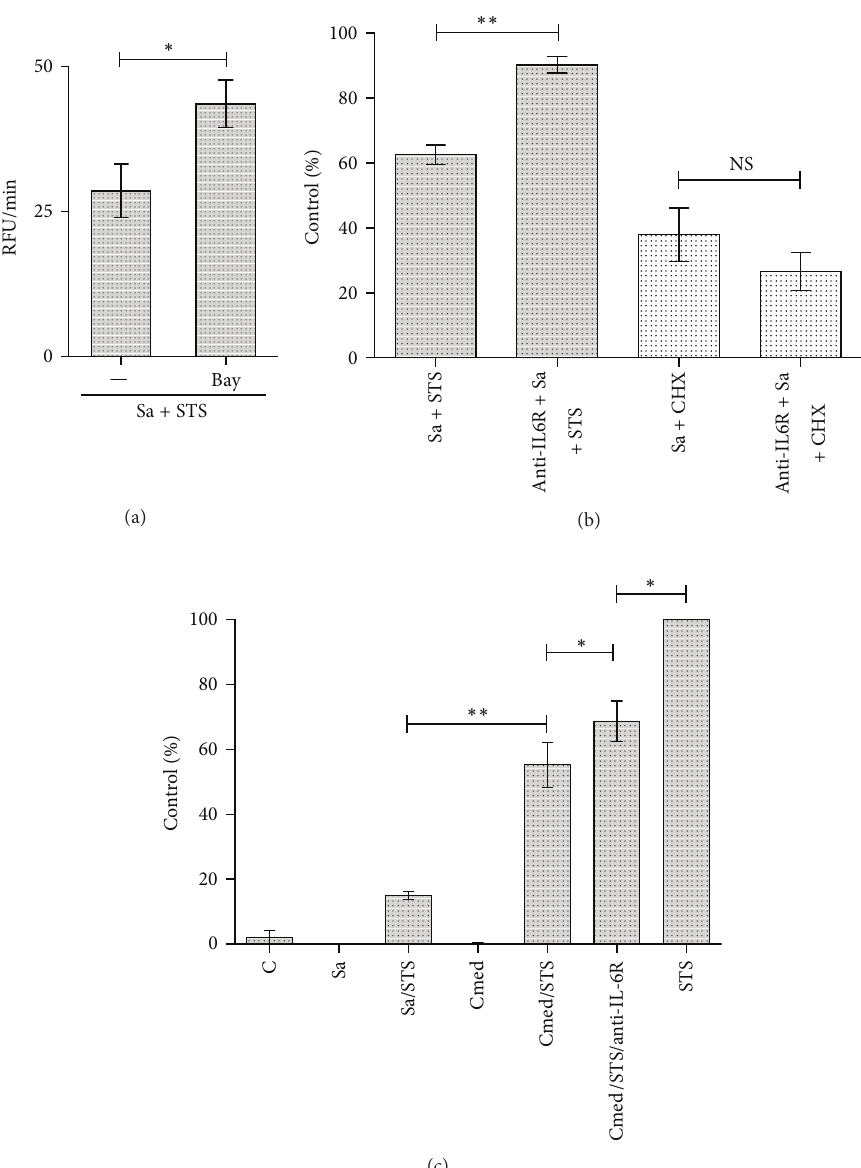
Binhibitorwasassessedbymeasuringcaspase-3activation.RAW264.7macrophageswerepretreatedfor30minwithBay11-7095 (4 M) followed by bacterial infection at an MOI of 5 for 2h. STS was added for an additional 3h, and then caspase-3 activity was measured in cell lysates (as described in Section 2). Data represent mean SD caspase-3 activity (RFU/min) from three separate experiments. 𝜅𝜅 (b, c) e in�uence of IL-6 on STS- (1 M) or CHX- (10 M) induced cytotoxicity in S. aureus- infected macrophages. (b) hMDMs were 𝜇𝜇 preincubated with anti-IL6 receptor antibodies (1 g/mL) for 1h followed by S. aureus infection at an MOI of 1:50 for 2. STS or CHX was ± added for 6h, and then permeabilisation of the plasma membrane or cell lysis was determined by measuring LDH activity in conditioned 𝜇𝜇 𝜇𝜇 media. Cell death aer treatment with STS or CHX alone was set as 100 . Diagram shows the mean values calculated from the results of 𝜇𝜇 three independent experiments using hMDMs derived from different donors. Bars represent mean relative expression NS: not signi�cant. (c) RAW 264.7 cells were infected with S. aureus (MOI 1:5) or stimulated with conditioned medium collected from % infected RAW 264.7 cells 5h p.i. alone (cmed) or with anti-IL6 receptor (1 g/mL) antibodies (cmed + anty-IL6R). At 2h aer stimulation, macrophages were treated with STS for another 4h and then caspase-3 activity was measured. Caspase-3 activation induced by STS alone was set as 100 . Shown are mean values calculated from the results of three independent experiments. Bars represent mean relative expression 𝜇𝜇 ; SD; % ∗ ∗∗ 𝑃𝑃 𝑃 𝑃𝑃𝑃𝑃 𝑃𝑃 𝑃 𝑃𝑃𝑃𝑃